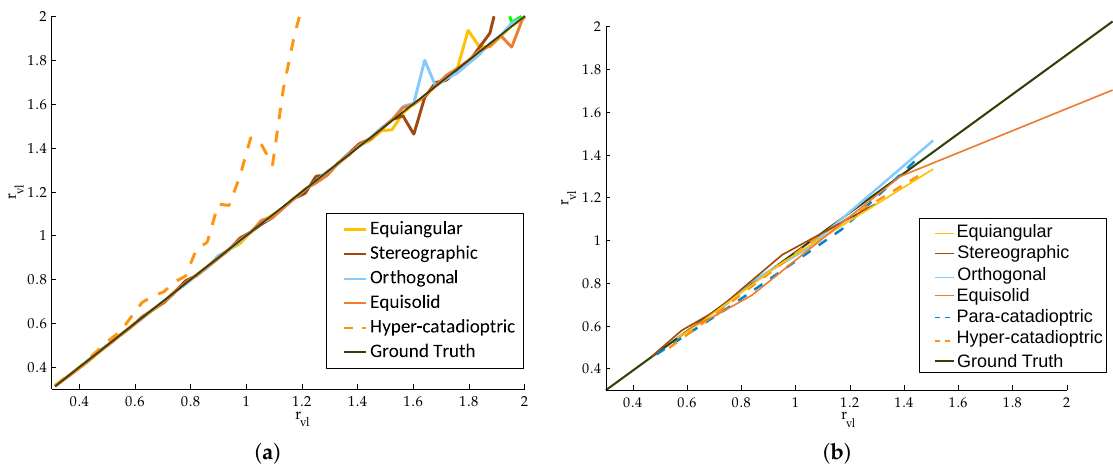
Figure 11. Normalized result for the calibration parameters using different omnidirectional cameras. ( a ): Calibration results from [34]; ( b ): Calibration results using images from our